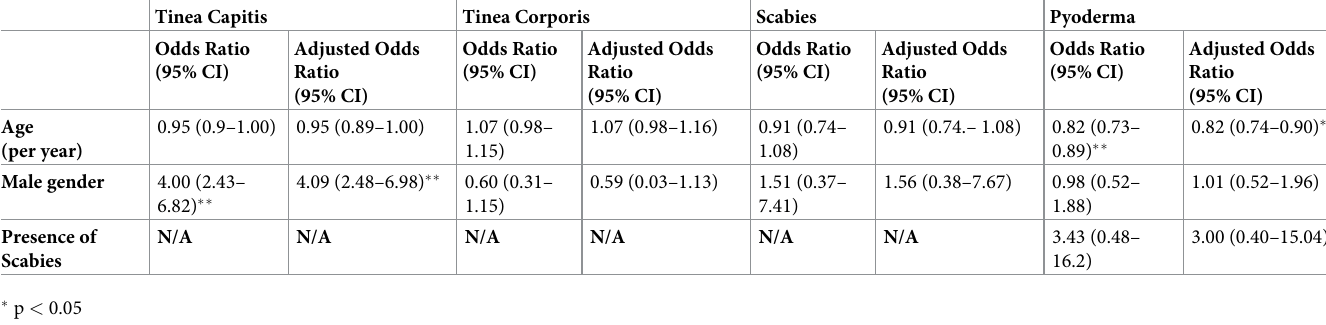
Table 2. Association between demographic factors and common skin dermatoses during the wet season survey. Tinea